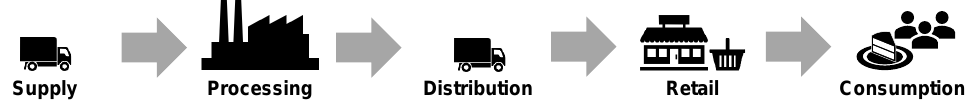
Figure 1. A simplified structure of the food supply chain (based on [10]) including the actors used to classify the digital twin applications within the scope of this work. The structure does not show any circular flows or side chains of by-, side-, or co-products, which would result in a value network rather than a straight-forwarded